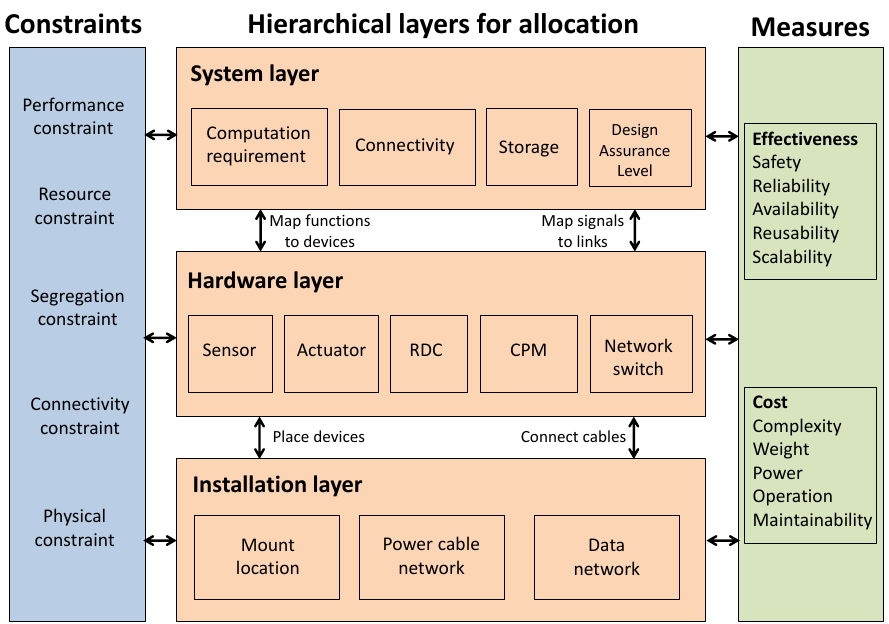
Figure 1. System architecture of DIMA. The design of system layer, hardware layer and installation layer is linked with a group of constraints and quality